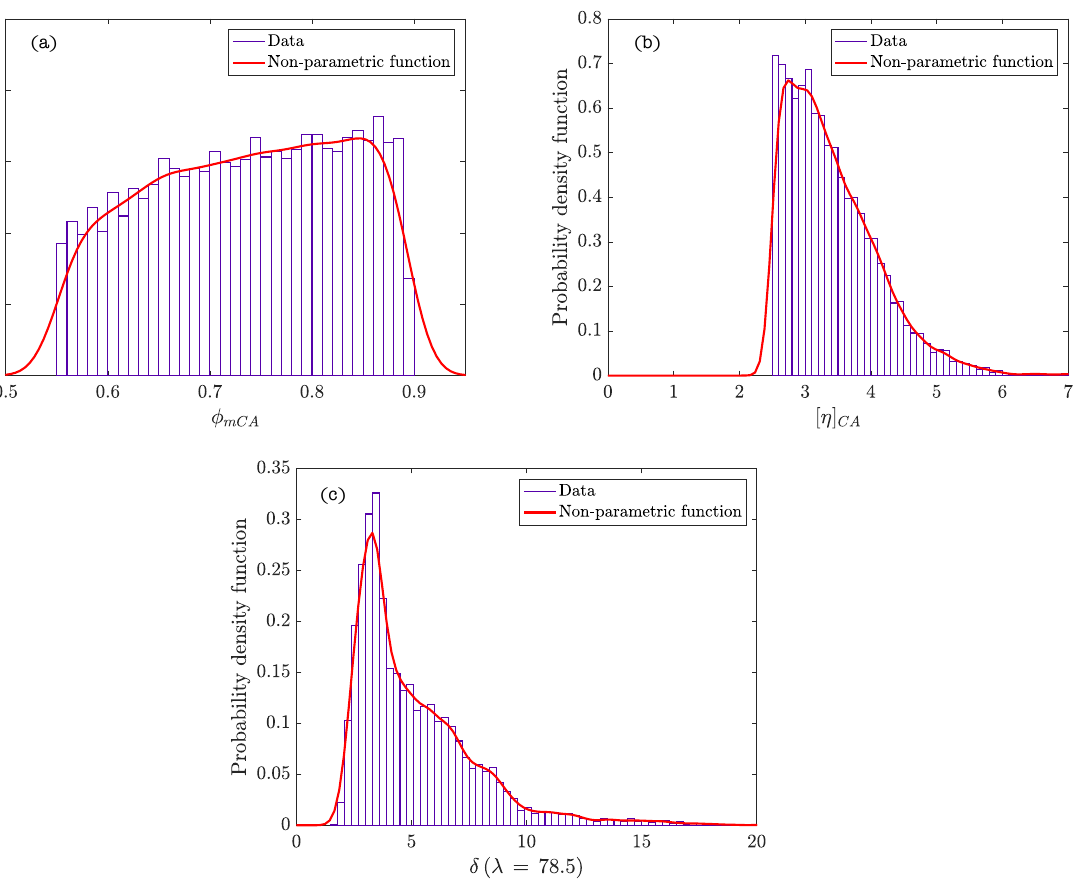
Figure 4. Probability density functions of φ m and [ η ] for the coarse granular phase (( a , b ), respectively) and δ parameter ( c ) in SCSFRC ( λ